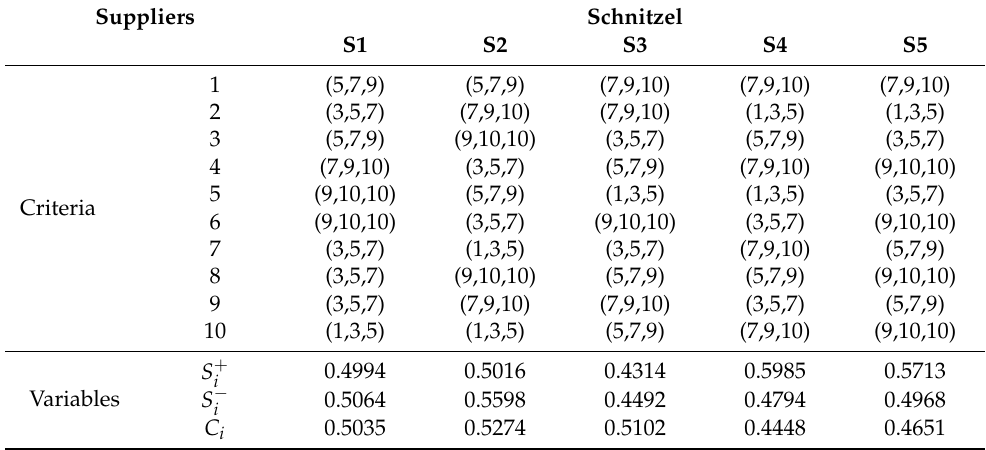
Table A13. Decision matrix considering suppliers and similarity index for schnitzel.